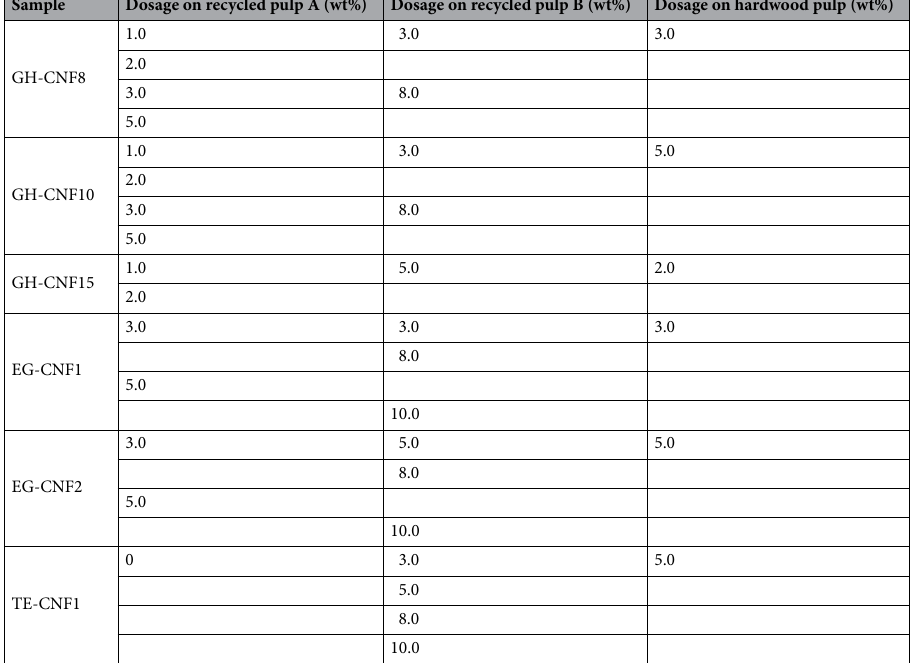
Table 2. Dosage of different CNFs on various types of